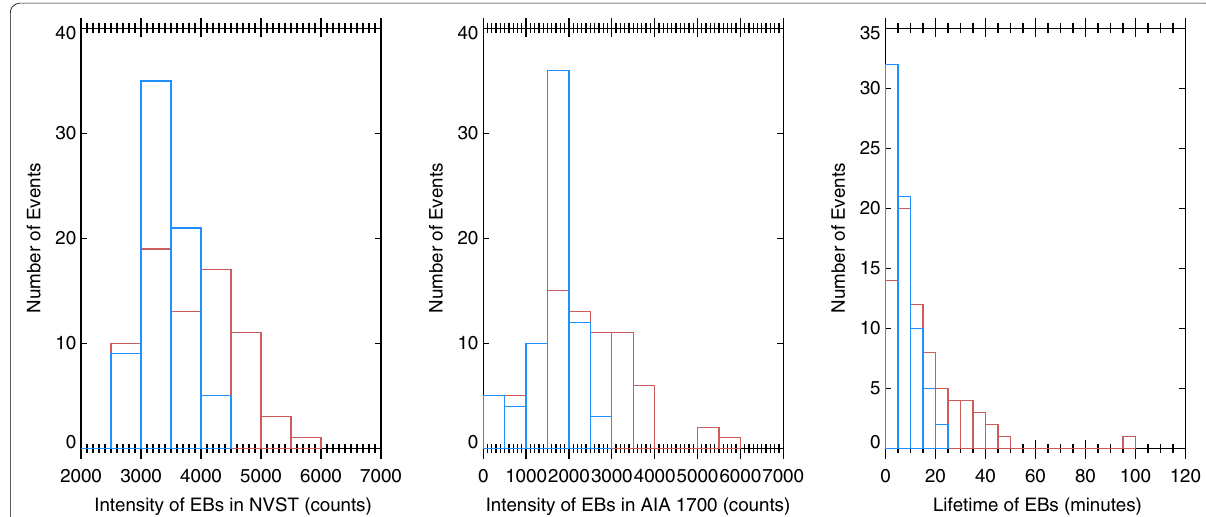
Fig. 4 Distributions of the intensities of EBs in the H α wing images, the AIA 1700 Å intensities at the locations of EBs, and the lifetimes of EBs derived from H α wing observations. The red and blue histograms represent the results for the BP-related EBs and EBs that are not related to BPs,